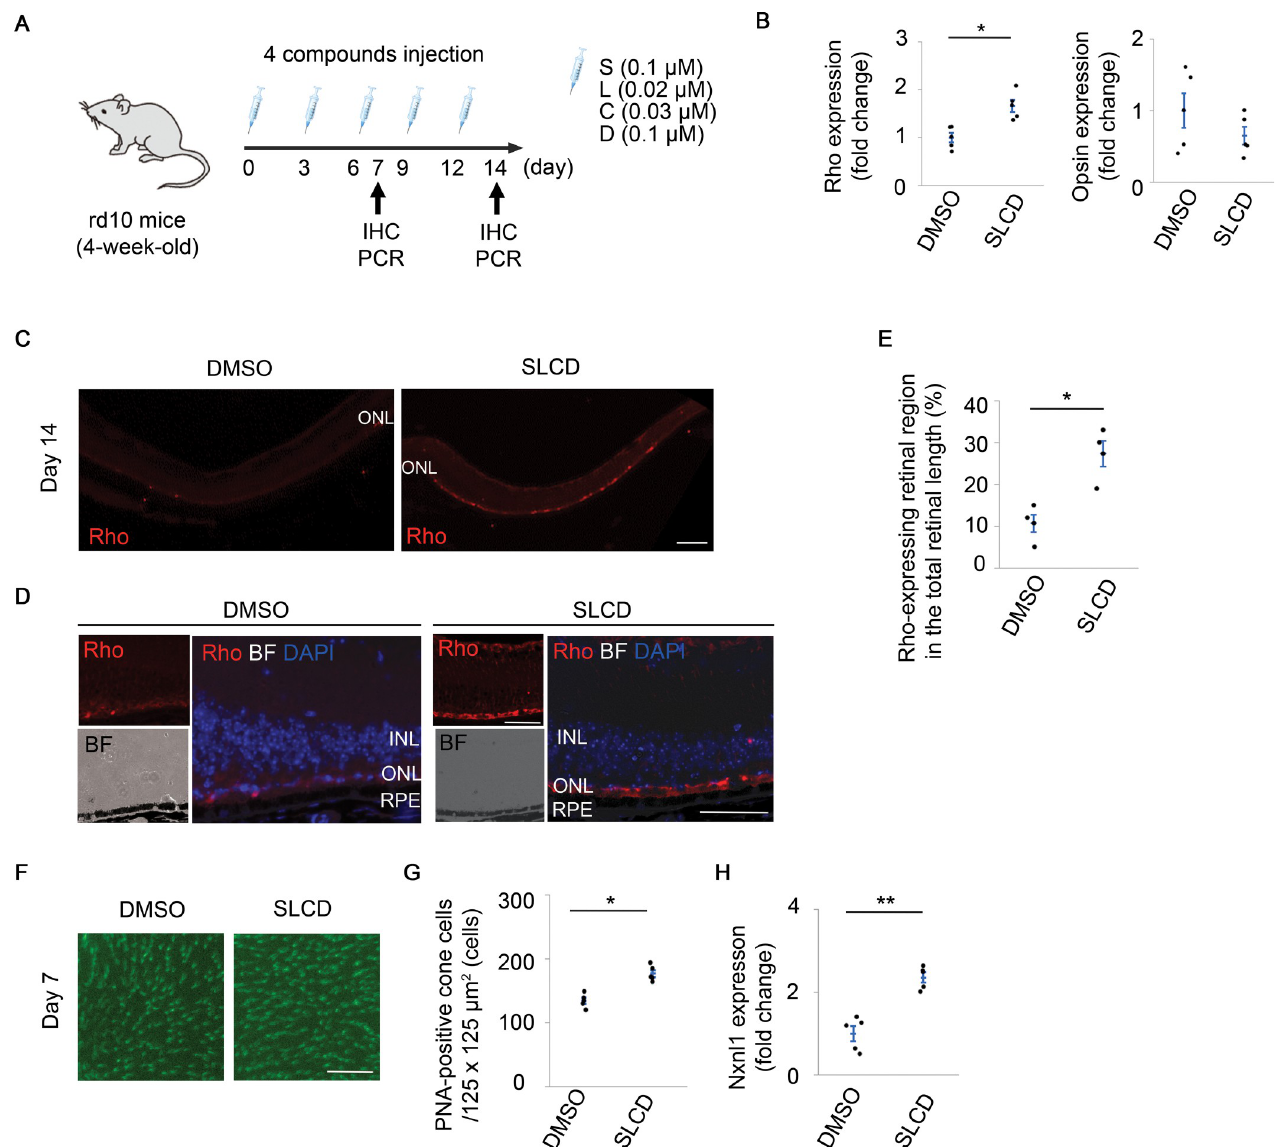
Fig 5. Contribution of the Rho-positive cells to the suppression of cone cell death in rd10 mice. A) Time course of the in vivo experiments using rd10 mice. An intravitreal injection of SLCD was performed every 3 days for 2 weeks from 4 weeks of age. B) Real-time qPCR results of the opsin and Rho expression in the whole retina on day 7 after the intravitreal injection of SLCD (n = 5). C) and D) Immunohistochemistry results of Rho (C) and quantitative results of the Rho-expressing retinal region in the total retinal length (D) on day 14 after the intravitreal injection of SLCD. Scale bar = 200 μ m (n = 5). E) Magnified images of Rho (red) expression and bright field in (C). Scale bar = 100 μ m. F) and G) Whole-mount PNA staining (F) and quantification of the PNA-positive cone cells (G) in the outer retinas on day 7 after the intravitreal injection of SLCD (n = 5). Scale bar = 50 μ m. H) Real-time qPCR results of NXNL1 on day 7 after the intravitreal injection of SLCD (n = 5). All data are presented as the mean ± SEM. � p < 0.05, as per Wilcoxon rank sum